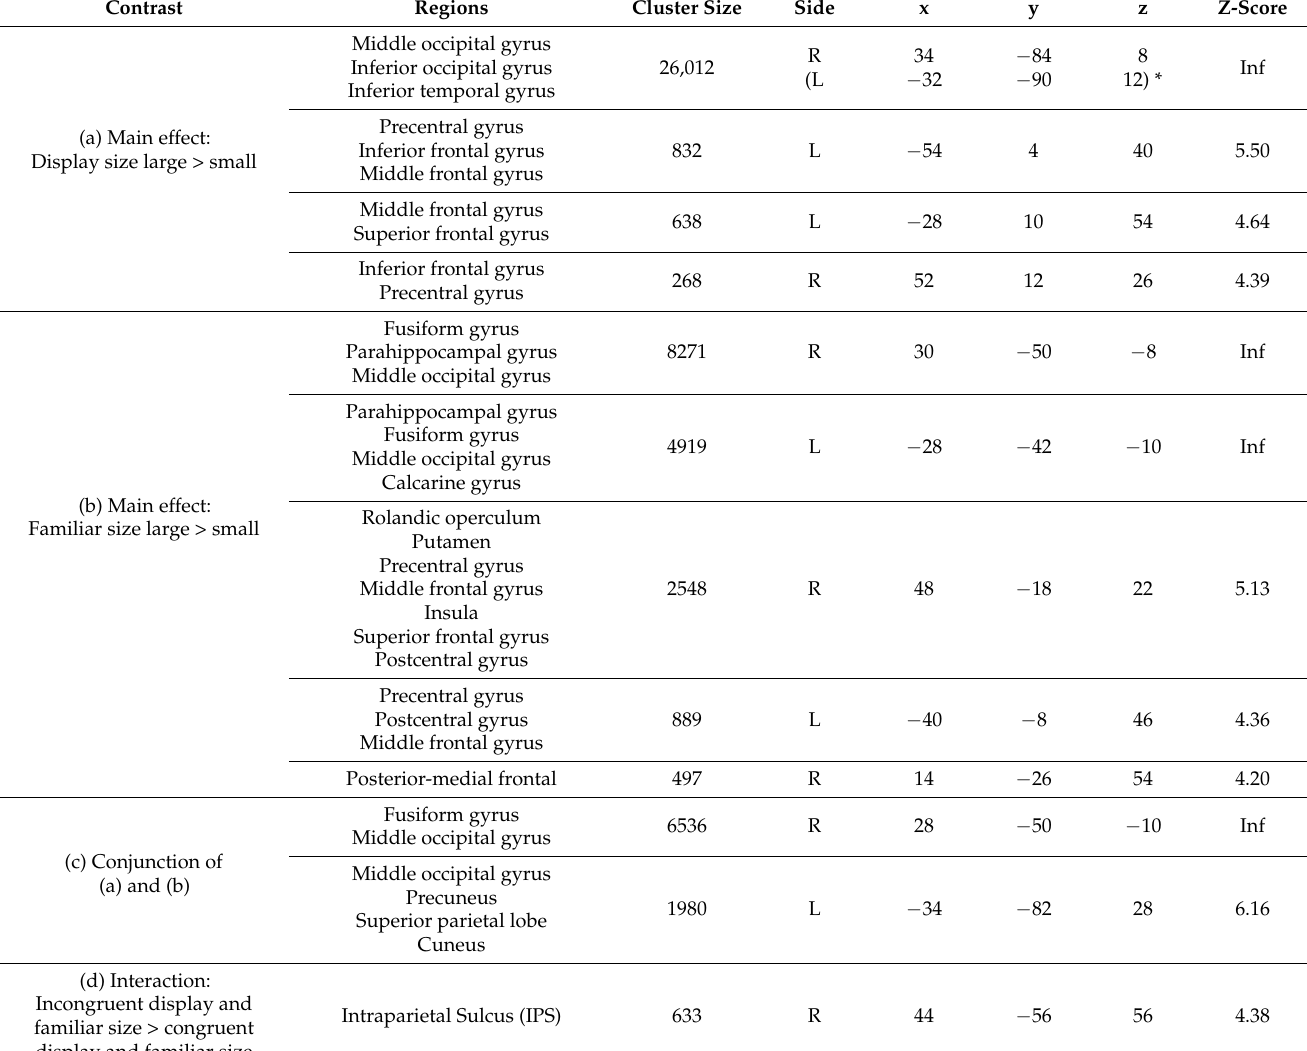
Table 1. Results of the second-level analysis of Experiment 1. Coordinates were defined within MNI space, and only the peak coordinates for each respective cluster are reported. Activations were all significant at p < 0.001 (uncorrected), with an extent voxel threshold that allows including the number of voxels of the smallest significant cluster at p < 0.05 (FWE). Regions were identified using the anatomy toolbox, as implemented in SPM 12